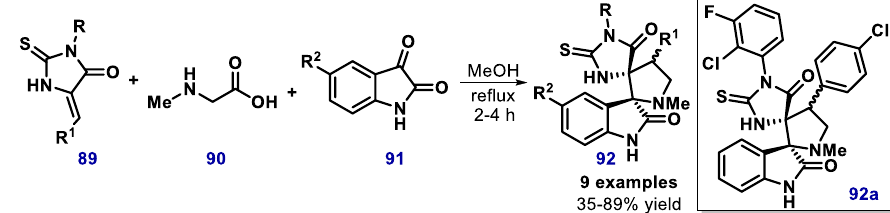
Scheme 23. Synthesis of spiropyrazoline oxindole derivatives by the Santos’